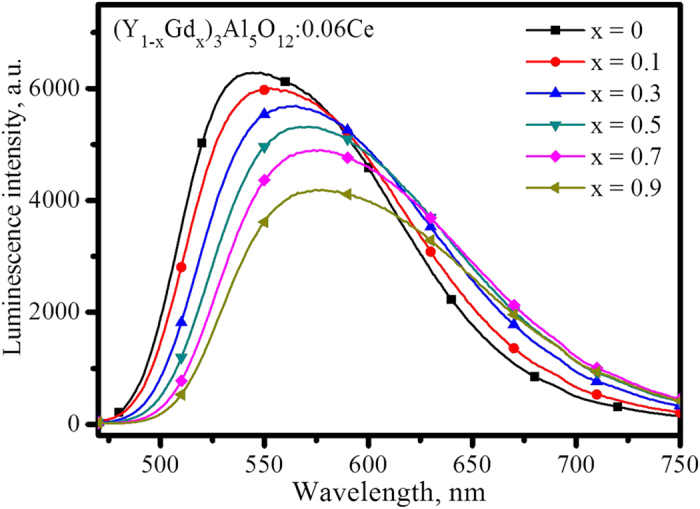
Emission spectra of (Y1−xGdx)3Al5O12 excited with 460 nm at room temperature.